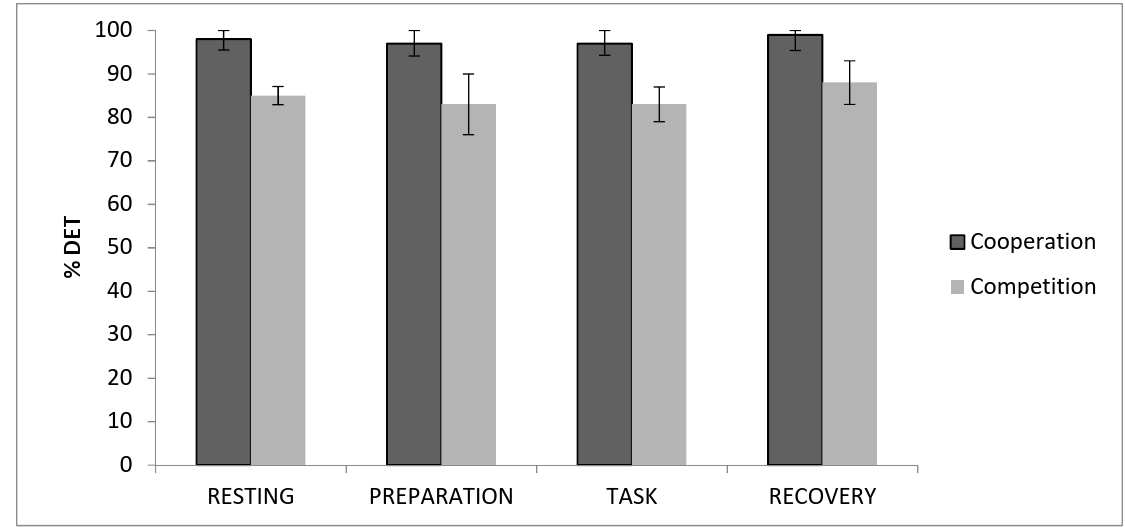
Figure 3. Galvanic skin response (GSR) percentage of determinism values for cooperation and competition groups.